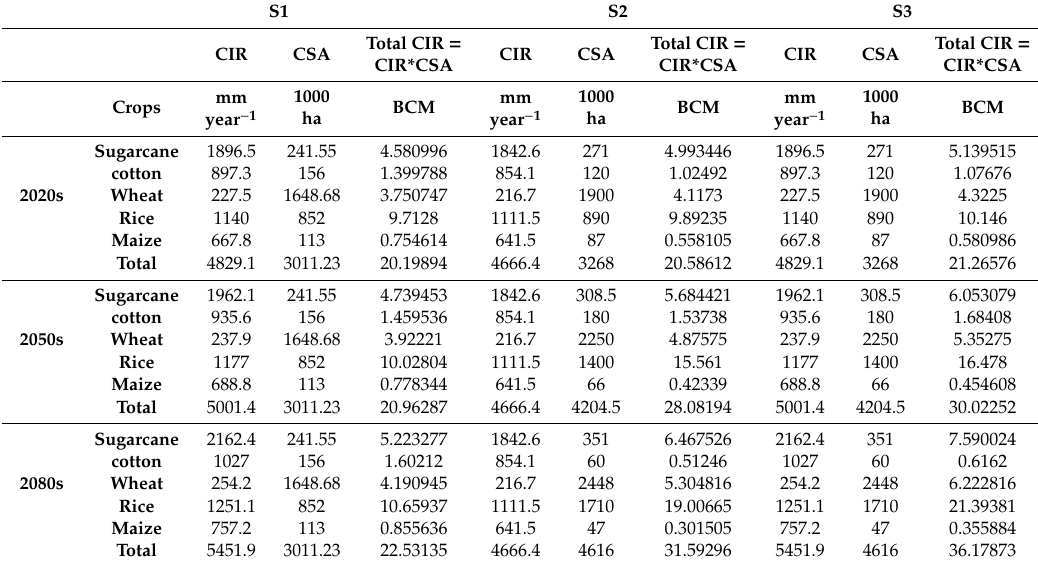
Table 7. Total CIR for di ff erent crops under H3B2 scenario with three di ff erent sub-scenarios S1, S2, and S3. * Note: CSA indicated crop sown